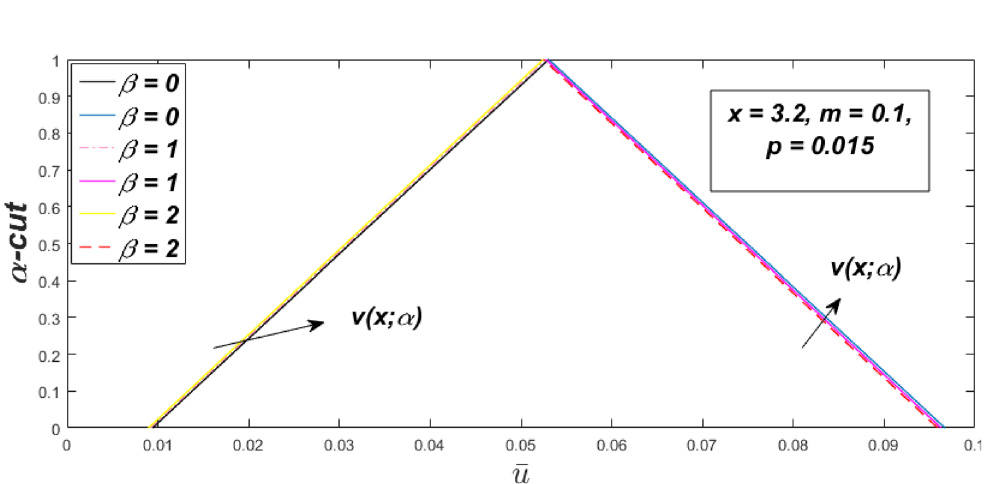
Figure 42. Triangular MF of fuzzy velocity for different values of β